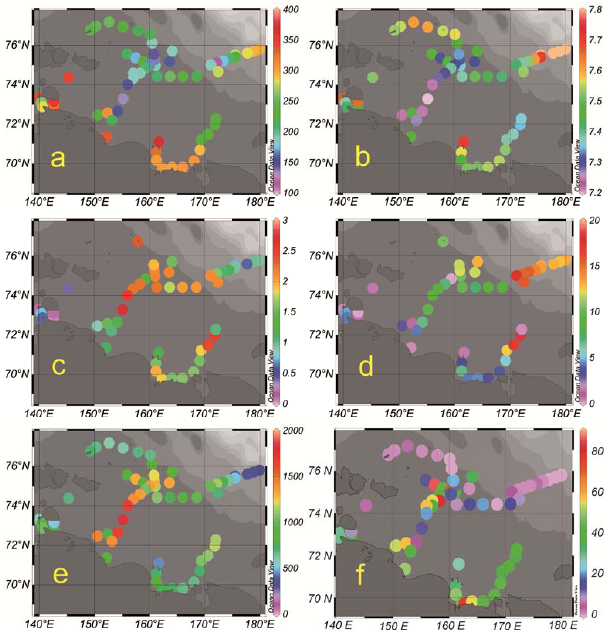
Fig. 9. Distribution of oxygen,µmolkg − 1 (a) , pH, seawater scale at 15 ◦ C (b) , phosphate,µmolkg − 1 (c) , nitrate,µmolkg − 1 (d) , f CO 2 ,µatm (e) and CH 4 , nM (f) in the bottom waters of the ESS.